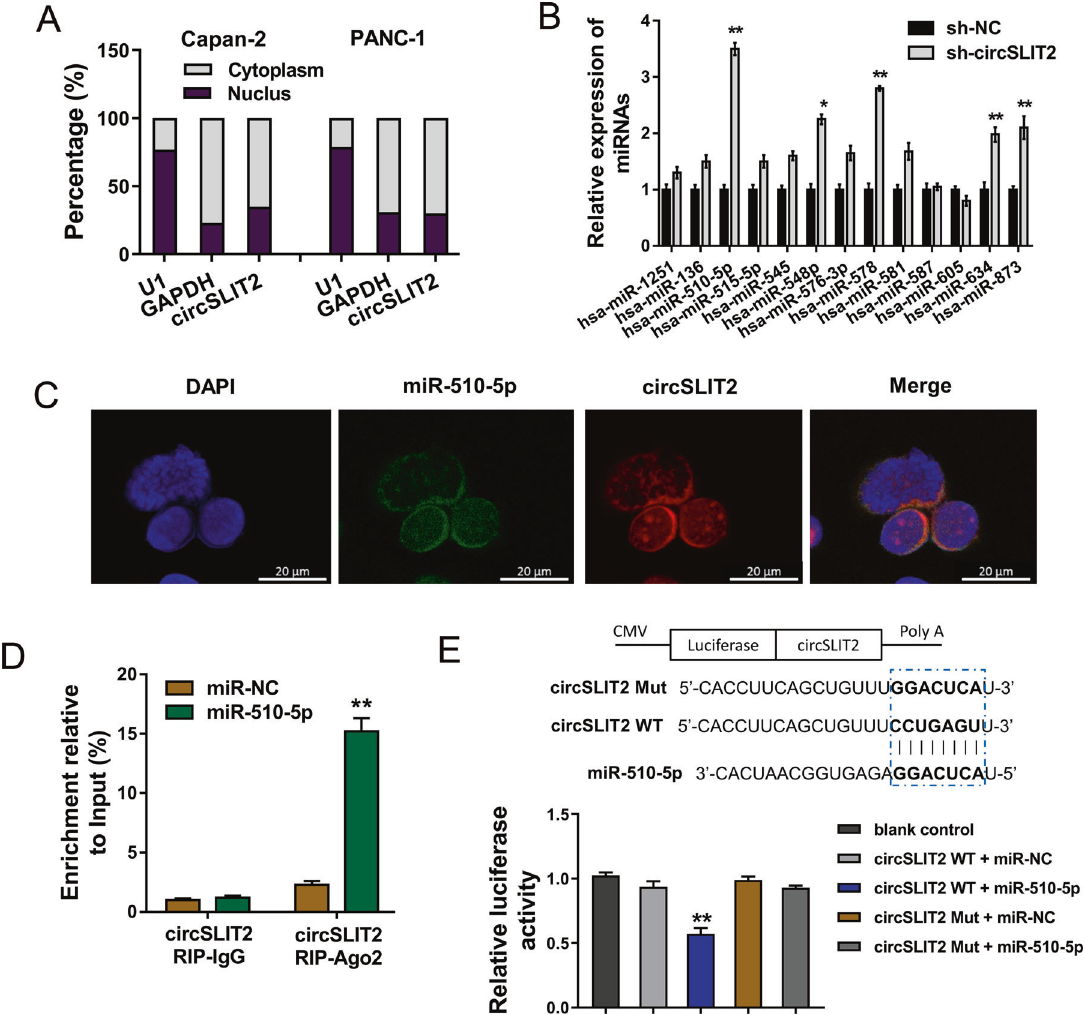
Fig. 4 MiR-510-5p served as the target of circSLIT2 in PDAC cells. A Subcellular fraction analysis indicated the cytoplasmic or nuclear distribution of circSLIT2. B Expression of miRNAs predicted by bioinformatics analysis (https://circinteractome.nia.nih.gov/) using RT-qPCR in PANC-1 cells transfected with circSLIT2 knockdown. C RNA fl uorescence in situ hybridization (RNA-FISH) unveiled the distribution of miR-510- 5p (labeled by FAM probe) and circSLIT2 (labeled by Cy3 probe). D RNA immunoprecipitation (RIP) assay was performed in PANC-1 cells to con fi rm the association between circSLIT2 and miR-510-5p. E The wild type (WT) correspond with miR-510-5p and mutant (Mut) vector for circSLIT2 were constructed. Luciferase reporter assay indicated the covalent binding within miR-510-5p and circSLIT2 wild type (WT) or mutant (Mut) vector. * p < 0.05; ** p <